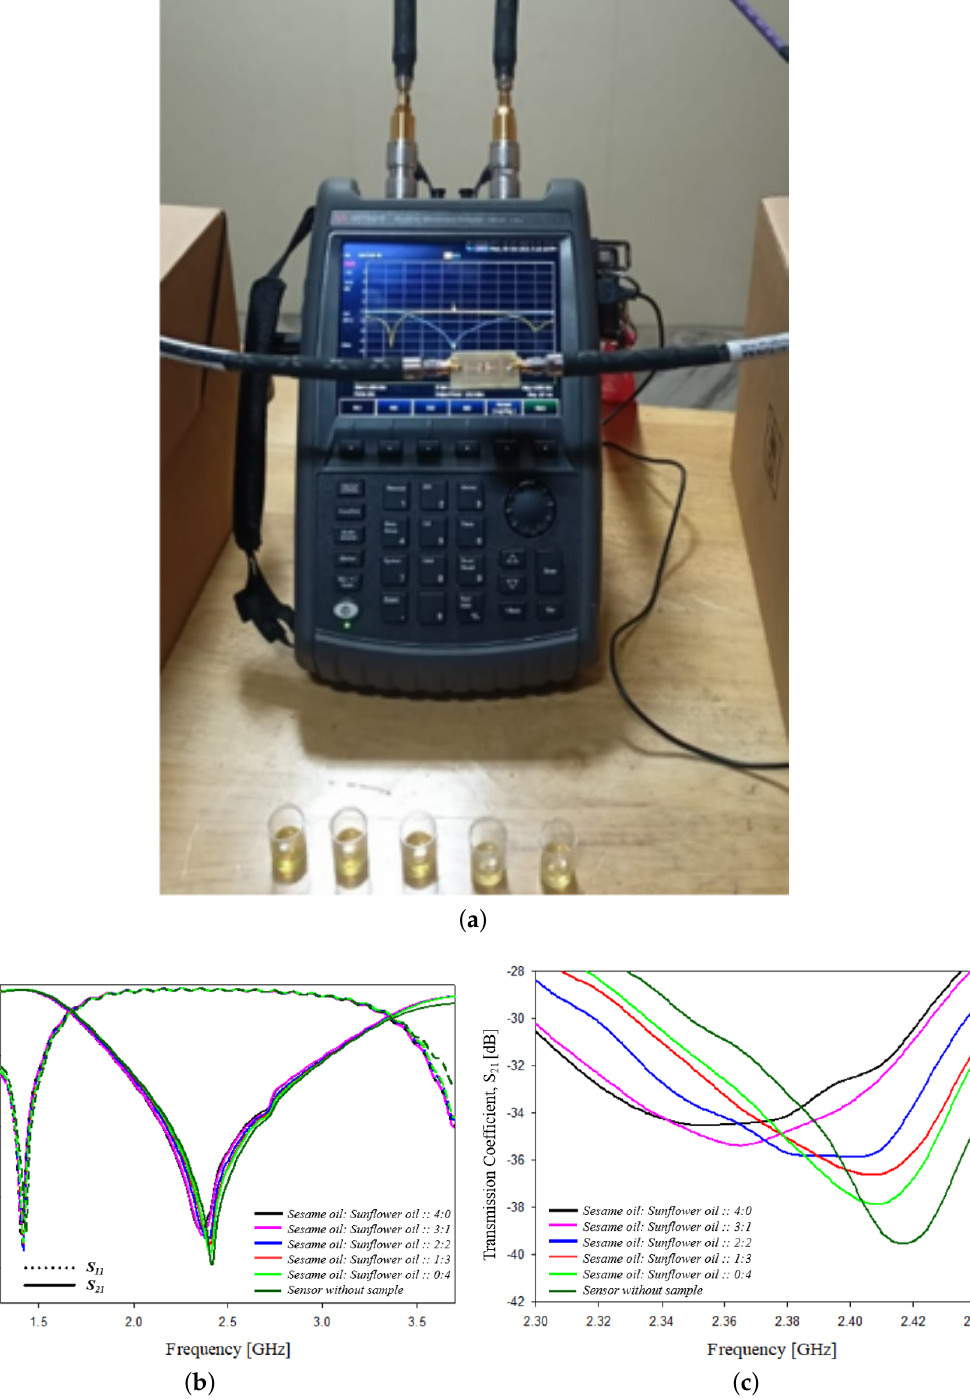
Figure 31. Adulteration testing in sesame oil: ( a ) experimental setup, ( b ) variation of scattering parameters with frequency and ( c ) variation of transmission coefficient parameters with